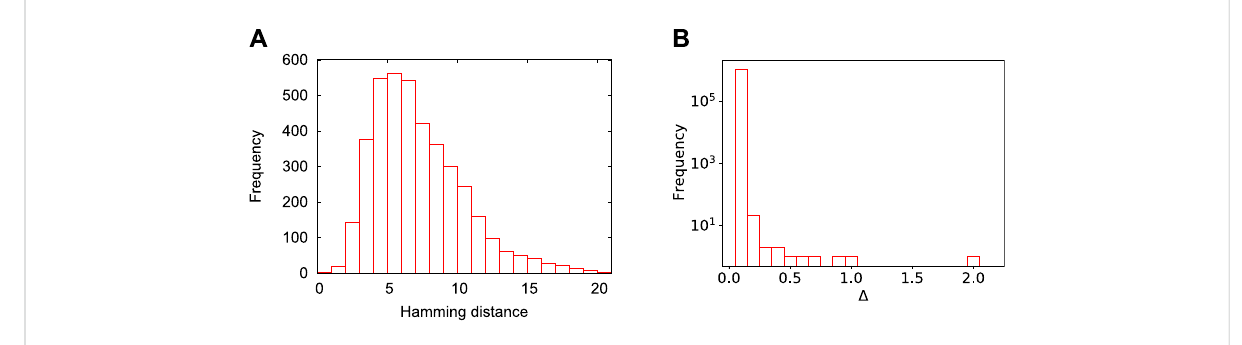
FIGURE 2 (coloronline)SameasFigure1exceptthattheprobleminstancebelongstotheclassof N =20RANproblemsandthatweonlyshowtheresults for the 4,000 states which are closest to the ground state in energy. In this case, the fi rst 4,000 excited energy levels differ by approximately 17 units whereas for 2SAT, the energy of 6,036 of the lowest excited states are only 4 units of energy higher than the ground state.